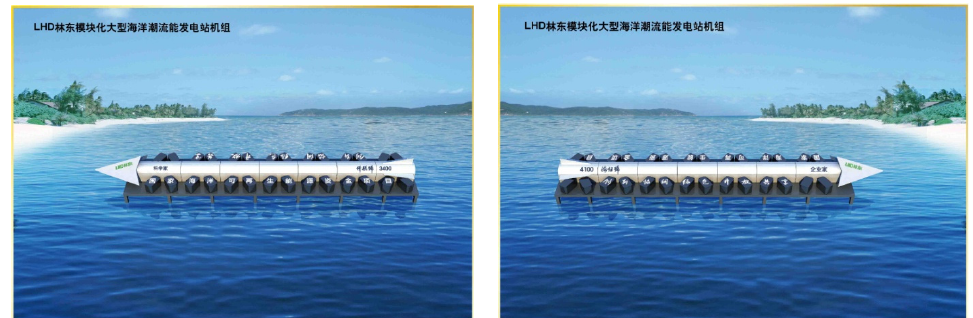
Figure 28. A 3.4 MW “Scientist · Overseas Chinese Federation” ( left ) and 4.1 MW Entrepreneur Overseas Returnee” ( right ). Reproduced from [74].